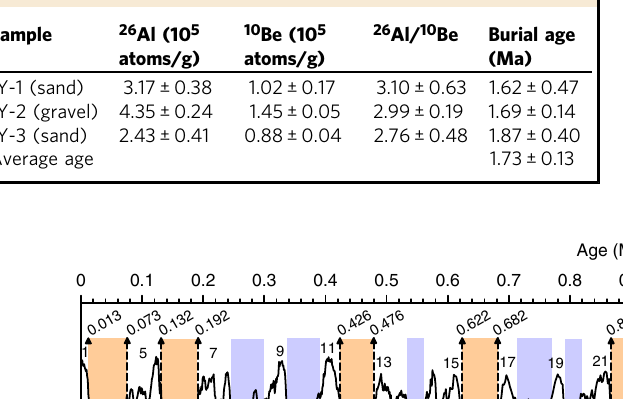
Table 1 Cosmogenic nuclide concentrations and burial age